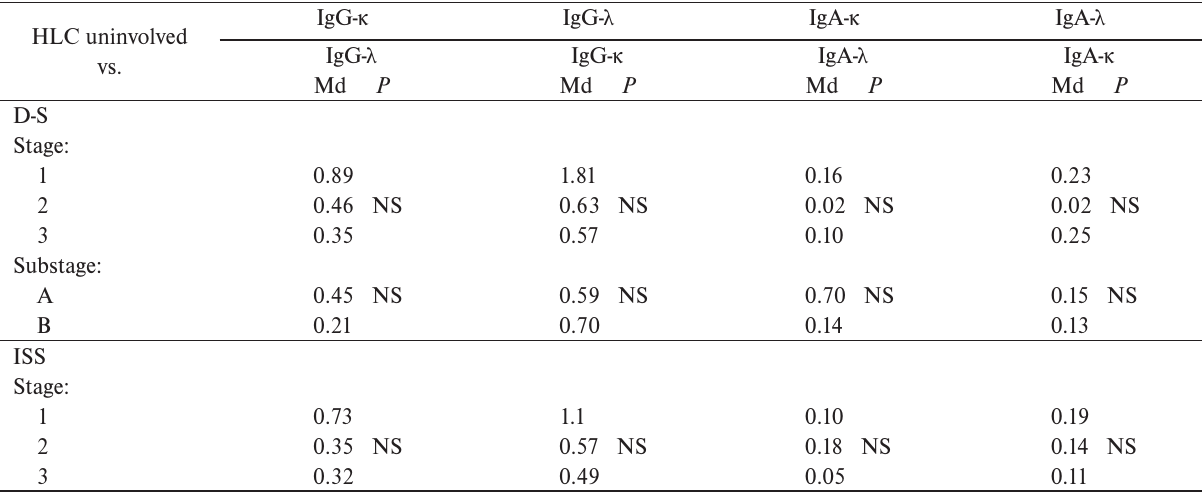
Table 5. Correlations of serum of levels if uninvolved HLC immunoglobulins and multiple myeloma stages classified according to Durie-Salmon and International Staging System in groups with different immunochemical isotypes of immunoglobulin. HLC uninvolved